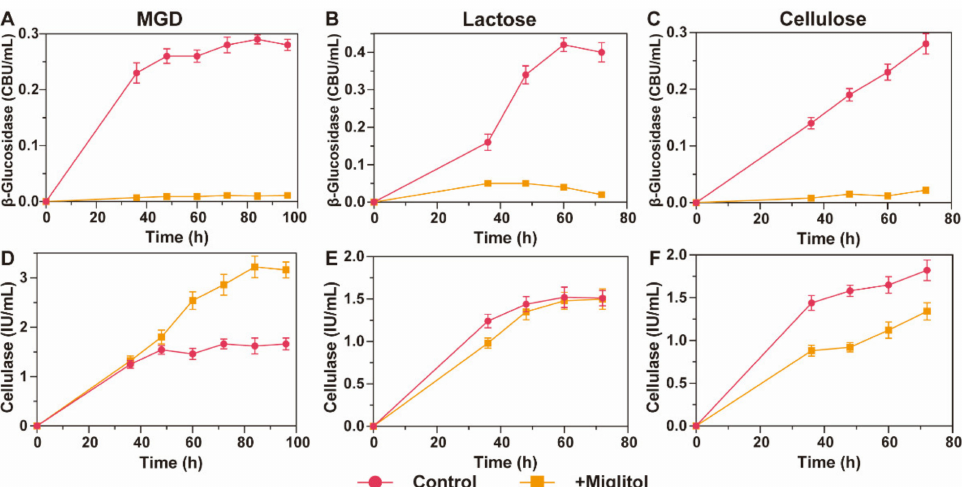
Figure 5. For cellulase and β -glucosidase activity after the addition of miglitol, time-course profiles of β -glucosidase ( A – C ) and cellulase activity ( D – F ) for T. reesei Rut C30 taking 10 g/L MGD ( A , D ); 10 g/L lactose ( B , E ); or 10 g/L cellulose ( C , F ) as the carbon source with/without miglitol. Bars denote the standard deviations for three independent